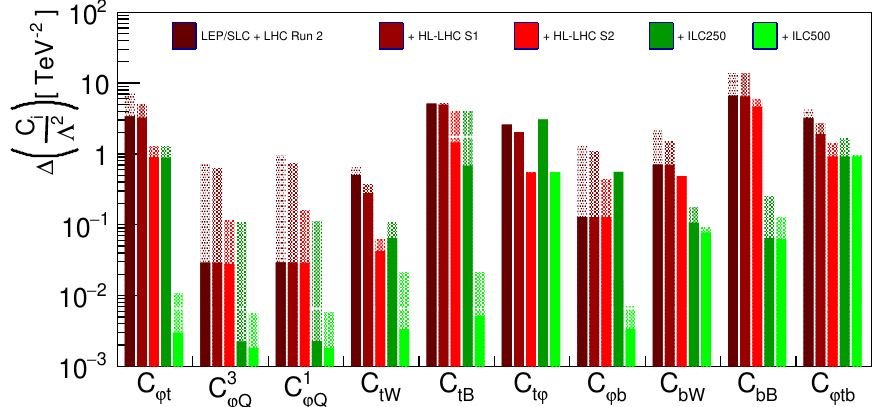
Figure 4 . Figure 4 of the paper. Prospects for the precision of the Wilson coefficients in future high-luminosity operation of the LHC and at a high-energy e + e − collider. Assumptions on the operating scenarios and details of the uncertainty estimates are given in text. The solid section of the bars represents the individual constraints, where each parameter is fitted in isolation, the full length indicates the marginalized constraint in a ten-parameter fit. The complete covariance matrices of the fits that are presented in this figure are available in appendix